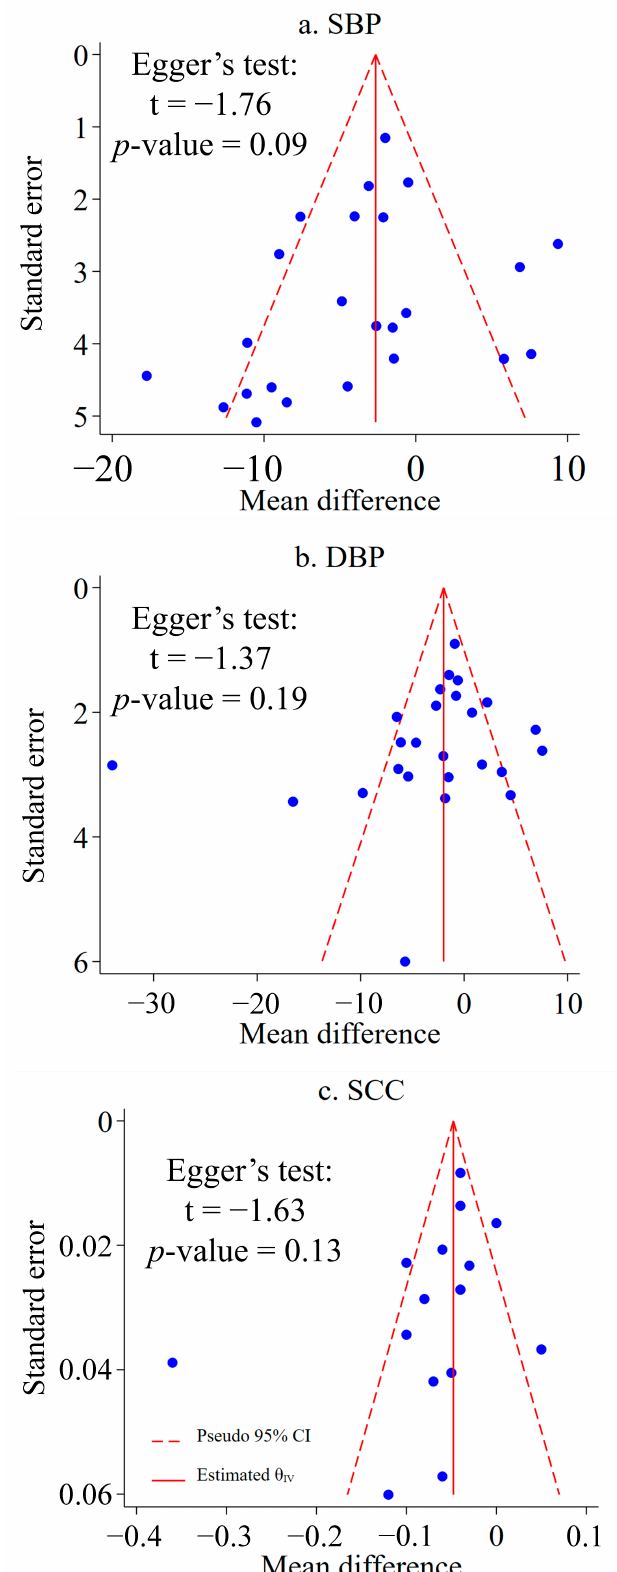
Figure 3. Funnel plots and Egger’s test for visual assessments of publication bias in the meta-analyses of forest therapy’s effects on SBP ( a ), DBP ( b ), and SCC ( c ) in urban residents. Blue symbols indicate included studies.